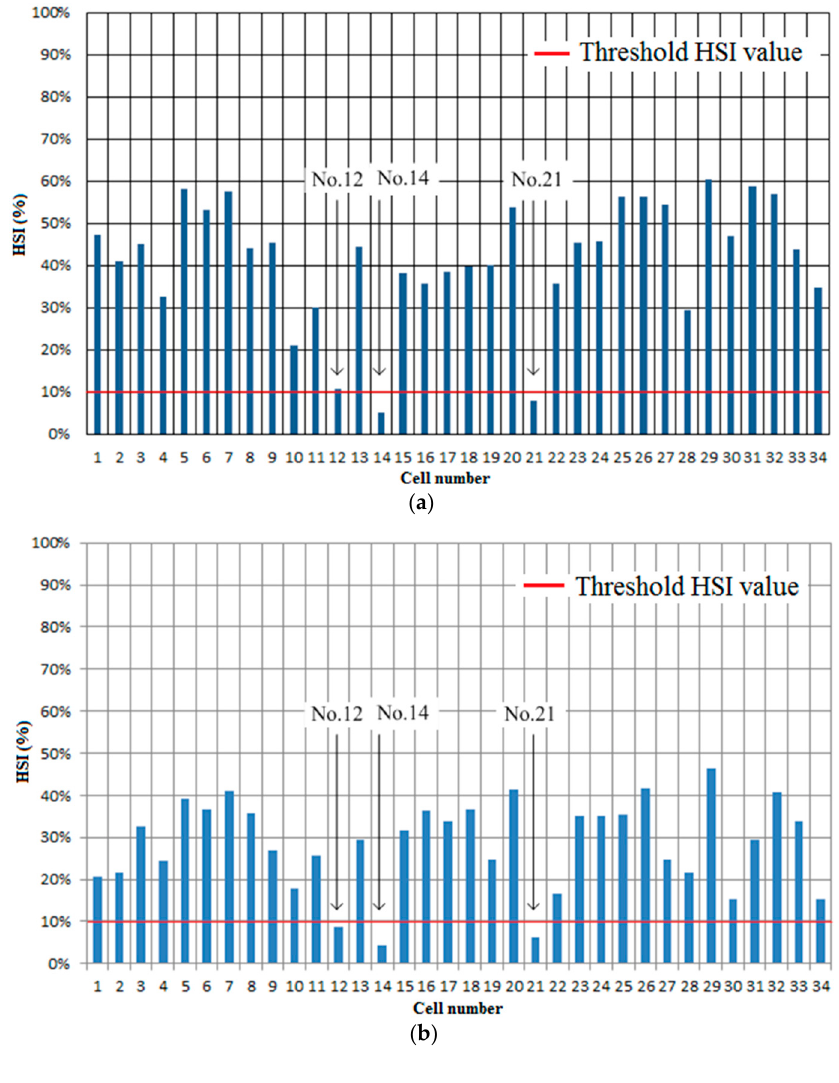
Figure 16. Correlation between HSI and illuminance: ( a ) Result of No. 2 module at 6000 Lux, the red horizontal line is the threshold HSI value; ( b ) Result of No. 2 module at 600 Lux.